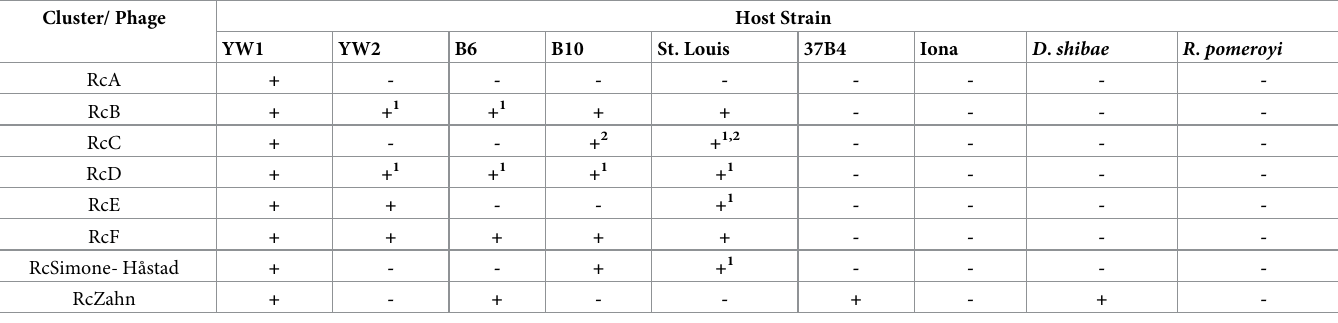
Table 2. Plaque formation using spot testing on various